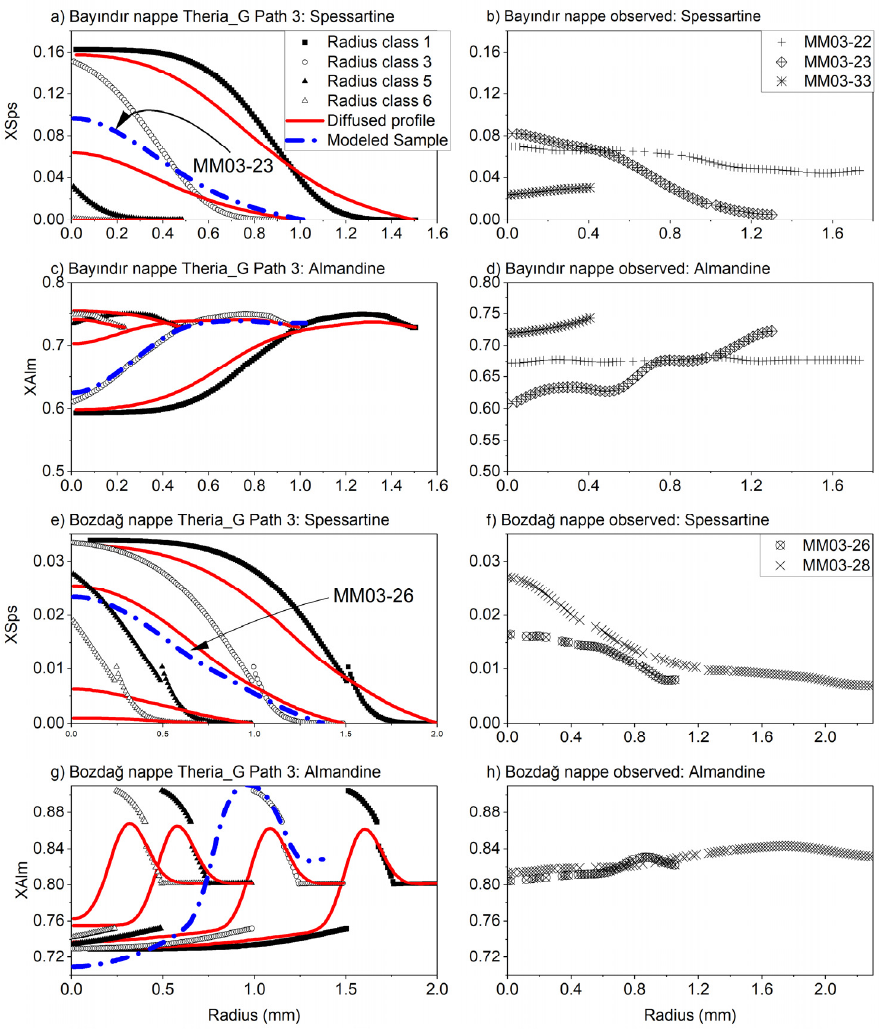
Figure 11. A comparison between Theria_G predicted garnet compositions for samples in the central Menderes Massif and actual garnet compositions determined by EPMA [23]. ( a ) Theria_G predicted spessartine compositions for an average Bay ı nd ı r nappe rock evolving along Path 3 (Figure 4a). ( b ) Observed spessartine content in a subset of samples from the Bay ı nd ı r nappe. ( c ) Theria_G predicted almandine compositions for an average Bay ı nd ı r nappe rock evolving along Path 3. ( d ) Observed almandine content in a subset of samples from the Bay ı nd ı r nappe. ( e ) Theria_G predicted spessartine compositions for an average Bozda ğ nappe rock evolving along Path 3. ( f ) Observed spessartine content in a subset of samples from the Bozda ğ nappe. ( g ) Theria_G predicted almandine compositions for an average Bozda ğ nappe rock evolv- ing along Path 3. ( h ) Observed almandine content in a subset of samples from the Bozda ğ